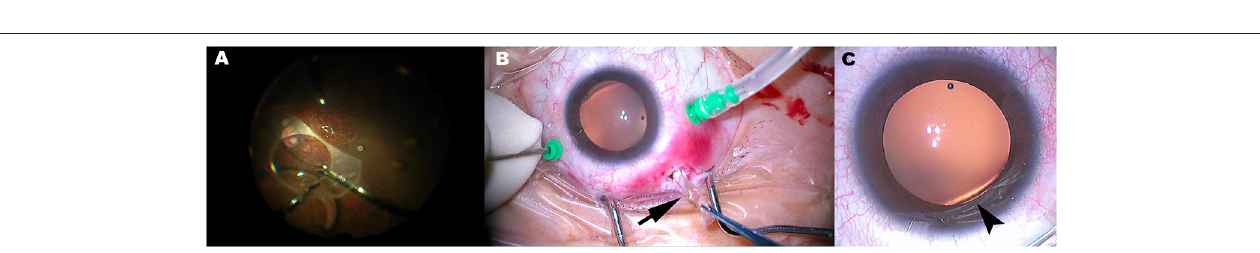
FIGURE 2 | The technique of EPRL removal and the rupture of zonular fibers. (A) The EPRL was grasped and cut into two equal pieces along the long axis. (B) Half of EPRL (black arrow) was extracted through a 2.5mm sclerotomy. (C) Rupture of zonular fibers and focal dislocation of the lens at nasal inferior (black arrowhead) was observed through an operating microscope when the patient lay on the operating